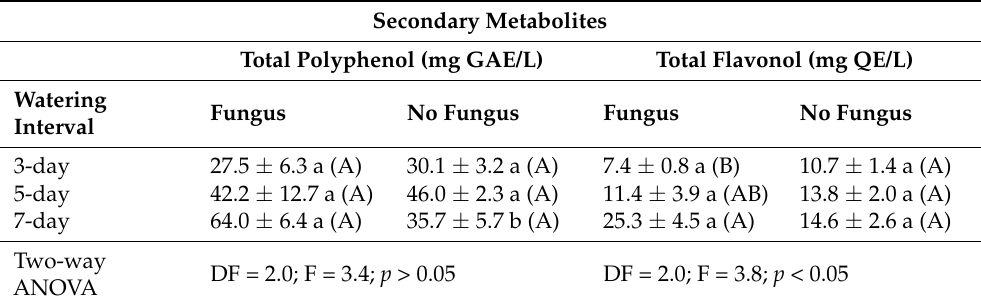
Table 4. The effects of B. bassiana inoculation and watering intervals on the secondary metabolite contents of A. cepa .